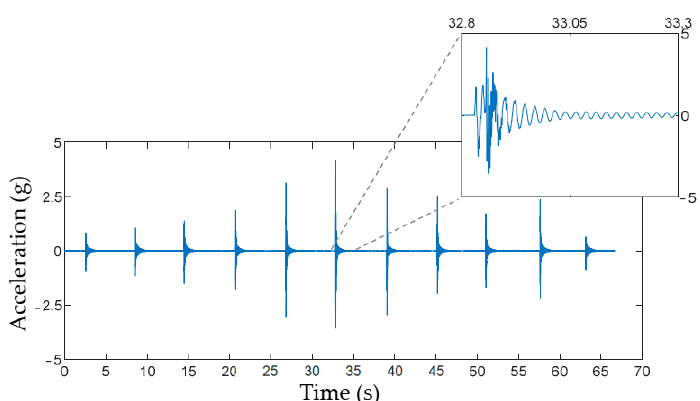
Figure 9. Vibrational response for the timber board #33 measured in the central accelerometer.